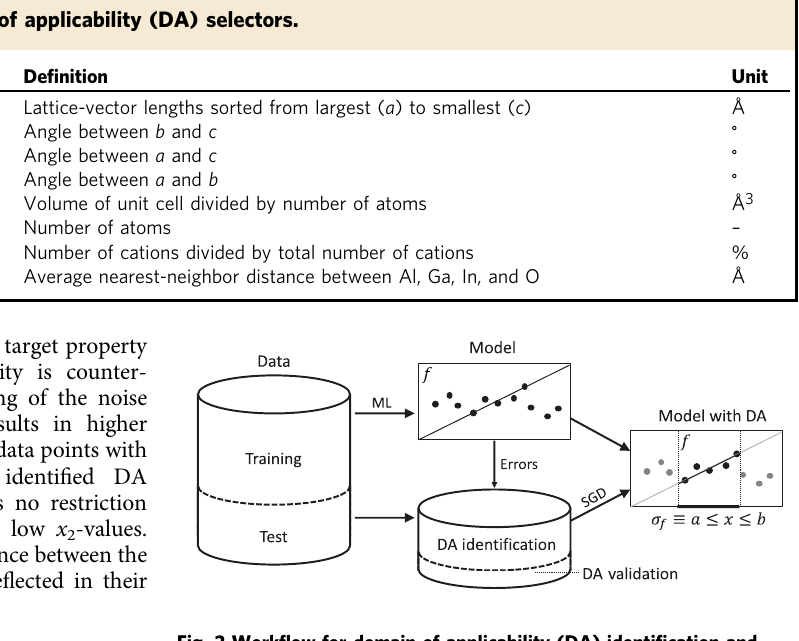
Fig. 2 Work fl ow for domain of applicability (DA) identi fi cation and validation for an ML model. The DA is described by a selector ( σ f ) that is comprised of logical conjunctions of a representation space (here symbolized by a single dimension x for simplicity but may be multidimensional). The selector is identi fi ed by applying subgroup discovery (SGD) to the individual ML-model errors for subset of test set (DA identi fi cation set). An unbiased estimate of the model performance within the DA is obtained on the remaining samples of the test set that were left out of the DA identi fi cation (DA validation